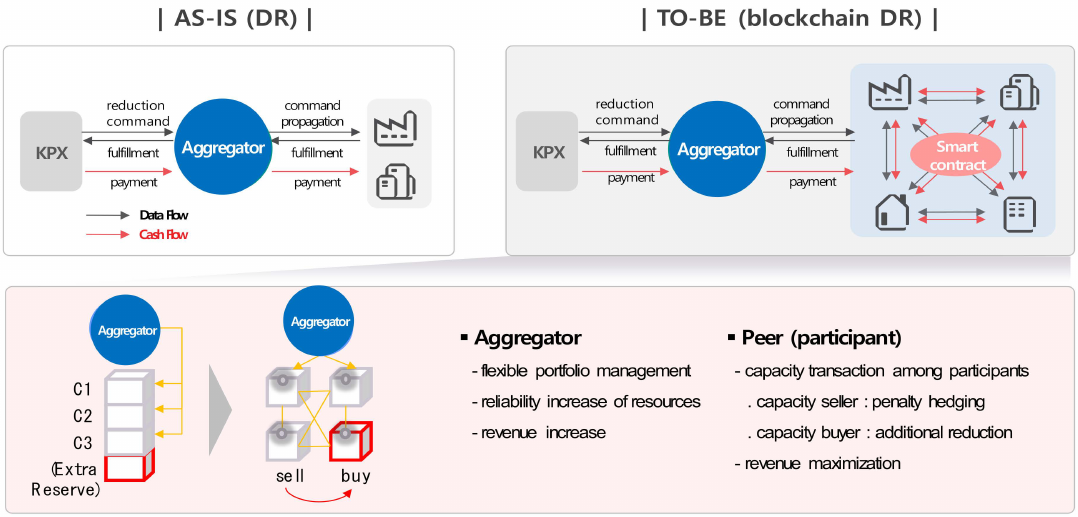
Figure 11. Conceptual diagram of blockchain-based DR